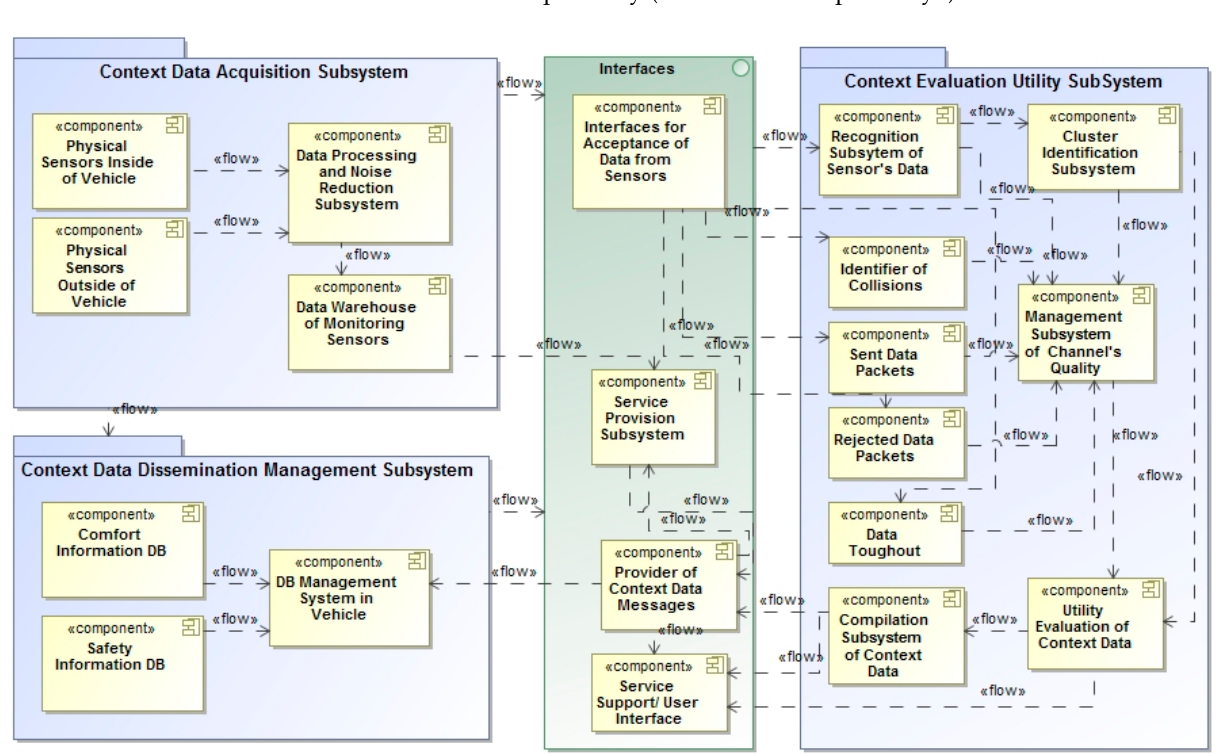
Figure 1. The architecture of the proposed IASDS for service support by recognition of data from sensors.